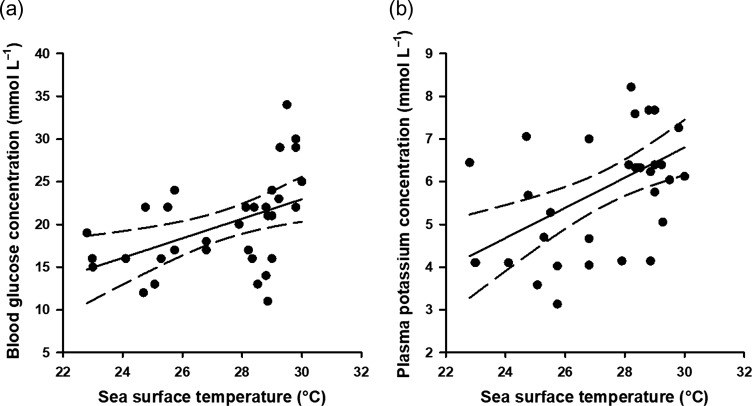
Relationships between sea surface temperature and physiological status of longline-caught nurse sharks (Ginglymostoma cirratum). Glucose concentrations (a) were measured from whole blood, and potassium concentrations (b) were measured from plasma. Dashed lines represent 95% confidence intervals.